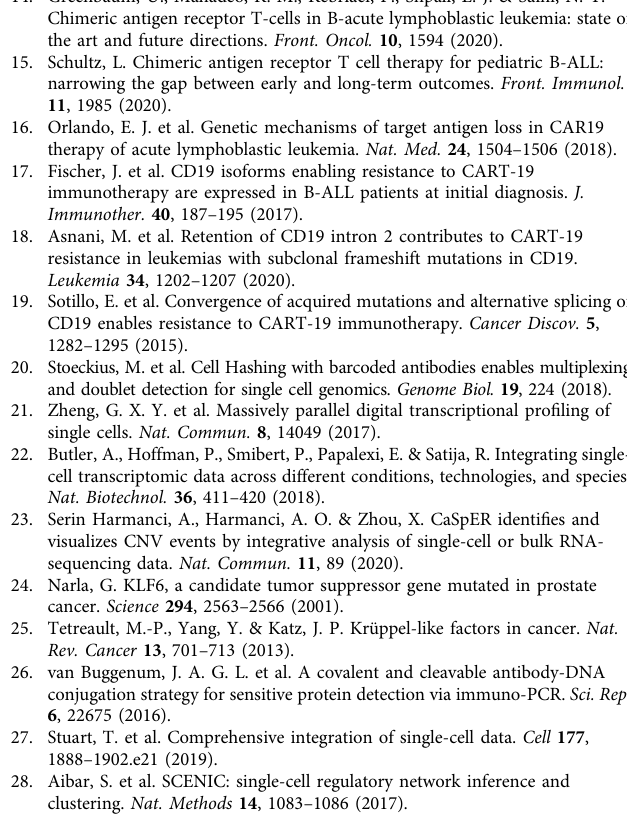
Fig. 2 Detection of CD19 neg B-ALL clones before CAR-T treatment. a UMAP plot focused on tumoral cells (clusters 0 and 1) and colored according to sample of origin. The 20 cells from T1-CD19 neg samples are highlighted by larger red dots. Sequences of 10× cell barcode (BC) of interest are indicated in Supplementary Table 1. b Heatmap showing normalized and scaled expression level of 20 genes differentially expressed between tumoral clusters (0 and 1), and either immature B cells (cluster 3) or mature B cells (cluster 4). Gene expression pro fi les of the 20 T1-CD19 neg cells are shown independently to the other B-ALL cells. Clusters 0, 1, and 3 were down-sampled to 100 cells for a better readability. Number of expressed genes detected in the various clusters are shown in Supplementary Fig. 10. c Dot plot of marker genes expression, same as Fig. 1b except that T1-CD19 neg cells from clusters 0 and 1 were analyzed independently, and that some differentially expressed genes between tumoral versus physiological cells were added. d Nested-PCR strategy to detect CD19 transcript in single cell. e Agarose gel of CD19 cDNA ampli fi ed by nested-PCR. Lanes are labeled according to the cell BC number for which the sample of origin is indicated at the bottom of the gel. Data are representative of independent backtracking experiments that were performed twice for cells with BC number 32, 33, 34, and 35; and three times for all other cells. Localizations on the UMAP plot of backtracked T2-CD19 neg cells are shown in Supplementary Fig.